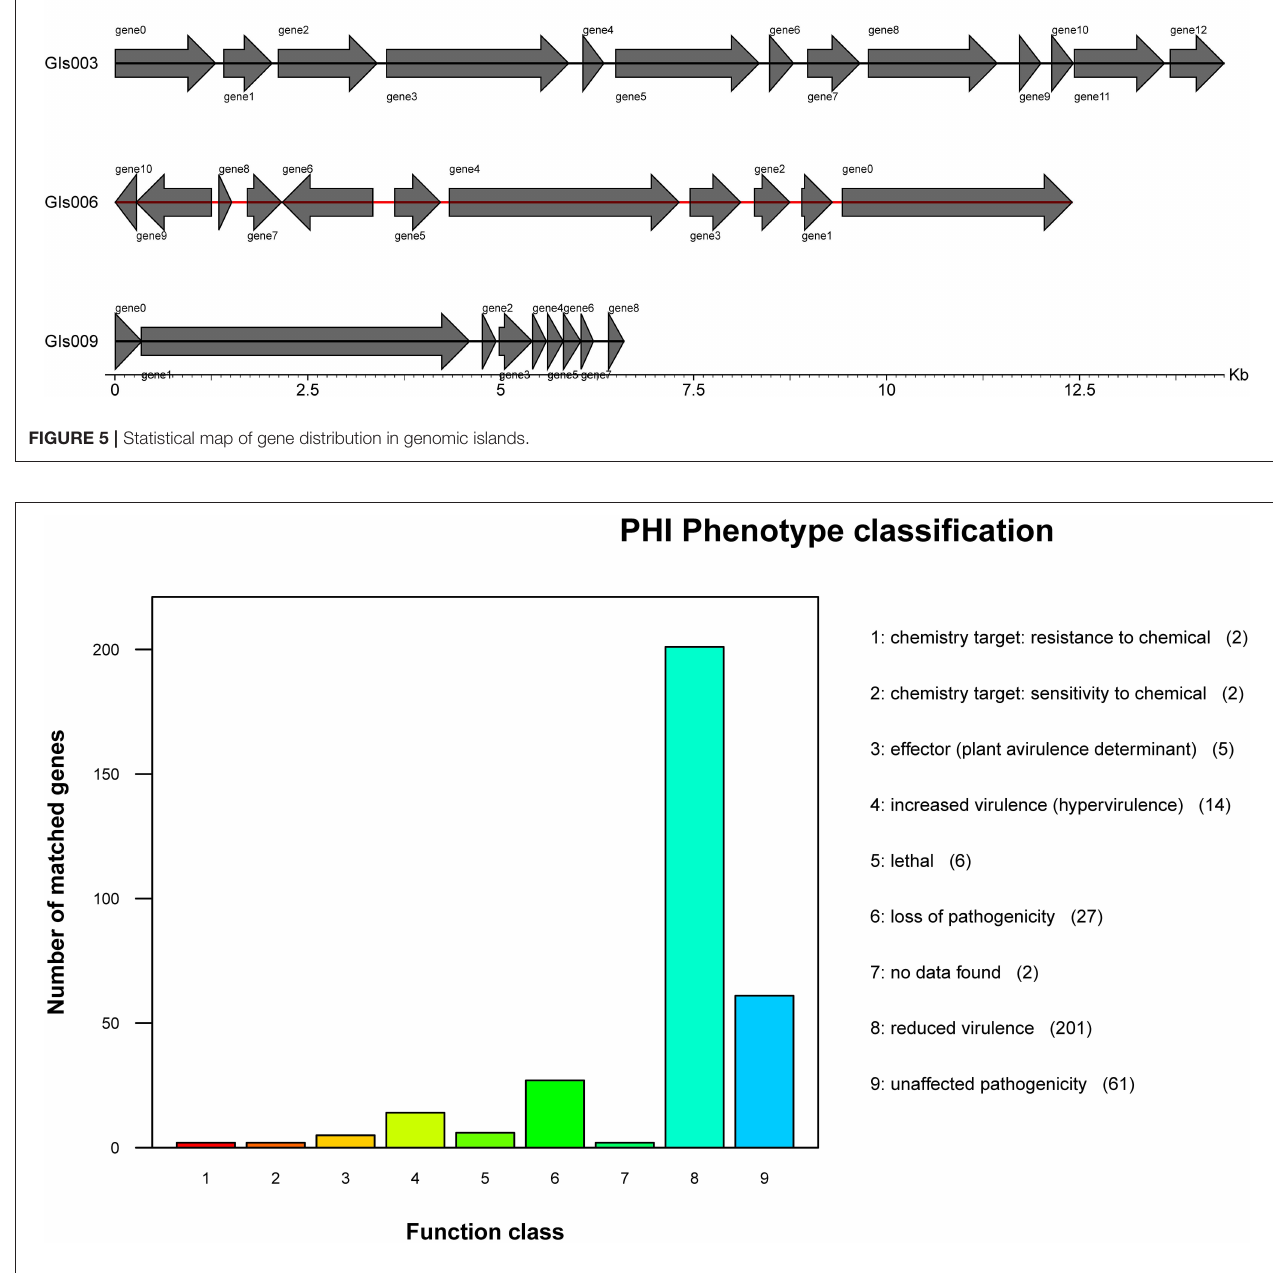
FIGURE 6 | Pathogen-Host Interaction (PHI) phenotype mutation type distribution